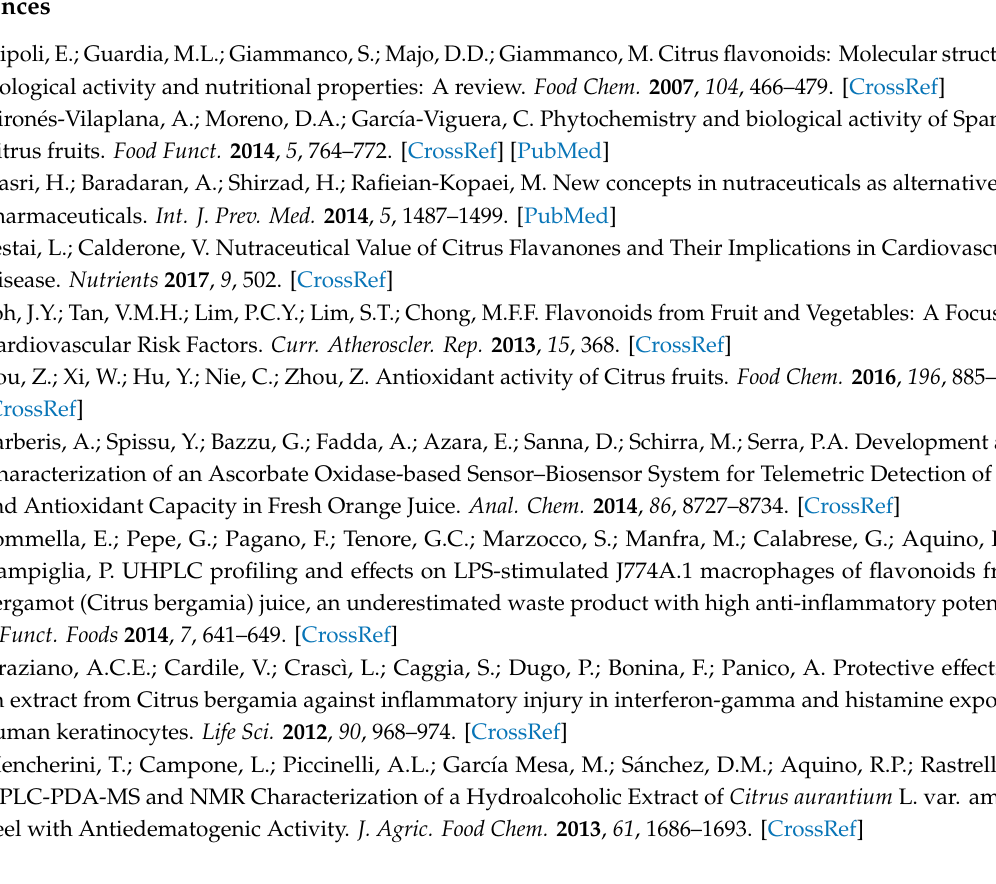
and orange ( cv Hamlin, Sanguinello and Moro) juice at concentrations between 10 and 500 µ g mL − 1 in medium, and incubated for 72 h; Figure S7. E ff ect of Pompia and lemon juices on cells number of CaCo-2 and SW48 colon cancer cell